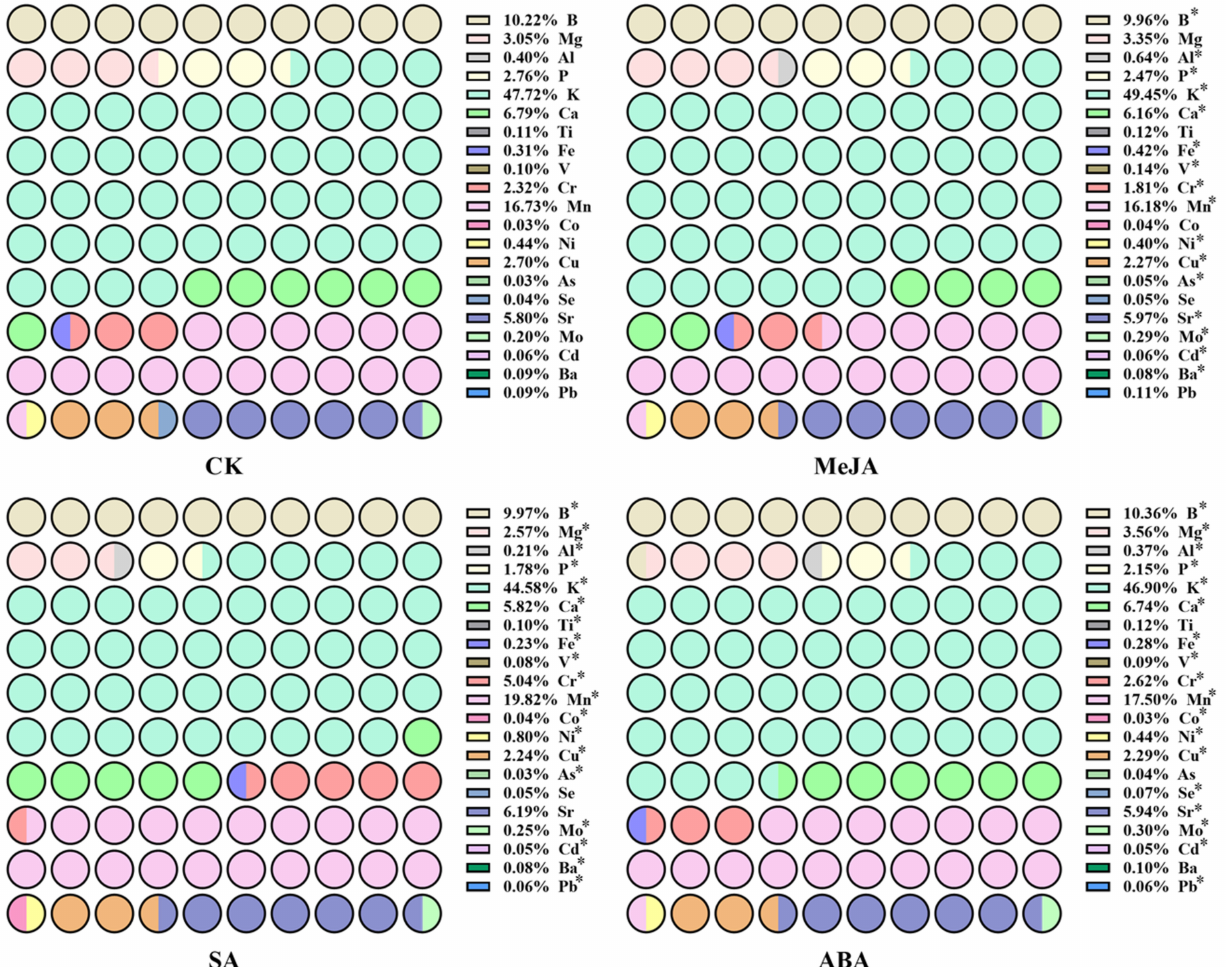
Figure 3. The proportion of 21 elements in A. argyi leaves under the CK, MeJA, SA and ABA treatments. * indicates that the treatment group and control group significantly differed at the 0.05